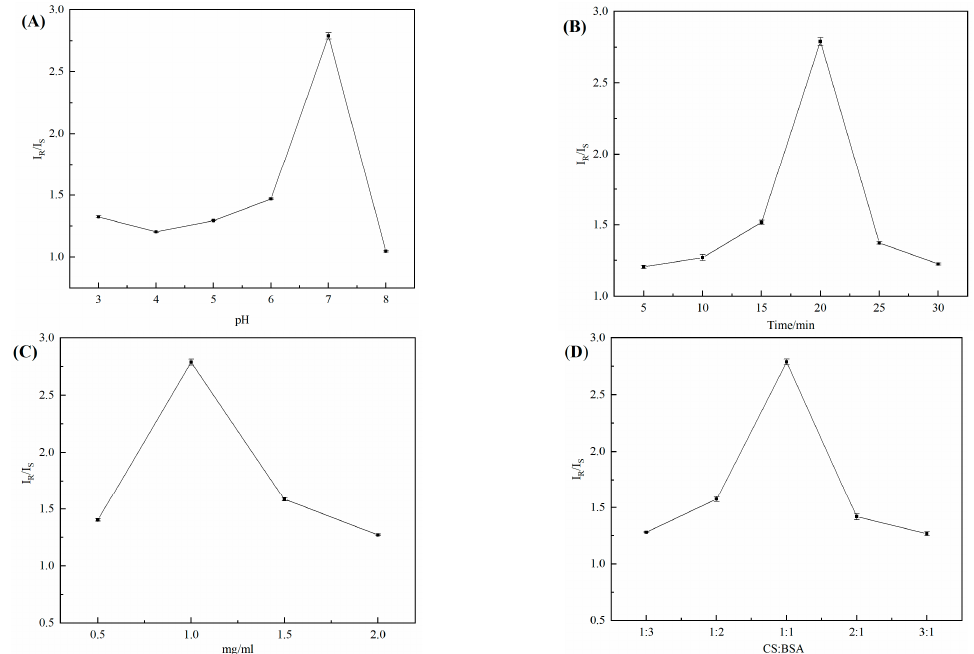
Figure 10. ( A ) At pH 3–8, the I R /I S of the R–/S–enantiomer; ( B ) the R–/S–enantiomer I R /I S at various times; ( C ) the I R /I S of the R–/S–enantiomer at a diverse concentration of rGO; ( D ) the I R /I S of the R–/S–enantiomers at di ff erent concentrations of CS and BSA. The optimized conditions were tested in a 0.1 M KCl solution containing 5 mM [Fe(CN) 6 ] 4 − /3 − solution. The amount of chiral selectors CS and BSA directly a ff ects the recognition perfor- mance of the electrochemical sensor. Prepare the mass concentration ratios of CS and BSA, which were 1:3, 1:2, 1:1, 2:1, and 3:1, respectively. Results of Figure 10D show that the mass concentration ratio of CS to BSA is 1:1 and the I R /I S is the highest. It may be due to the excessive amount of BSA decreasing the viscosity of the electrode surface, which reduces the stability of 3D–rGO–CS–BSA and makes the recognition e ff ect less than ideal. At the same time, the exorbitant amount of CS will lead to more CS being exposed, which will hinder the combination of the chiral selector BSA and the enantiomer and decrease the recognition e ff ect. When the concentration is 1:1, the peak current di ff erence is the most